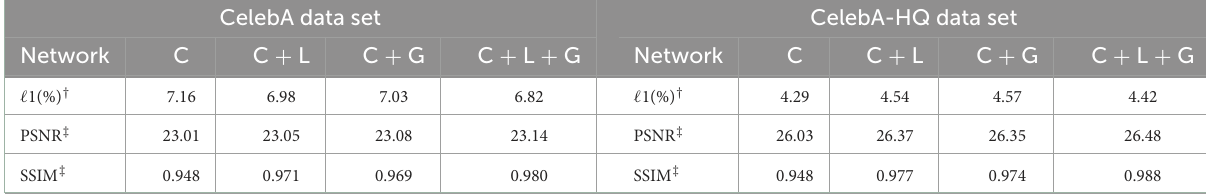
TABLE 3 The ablation of network design on CelebA and CelebA-HQ data sets. CelebA data